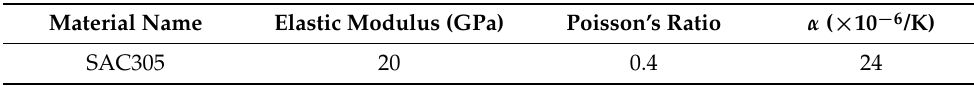
Table 2. Mechanical properties of the matrix material.